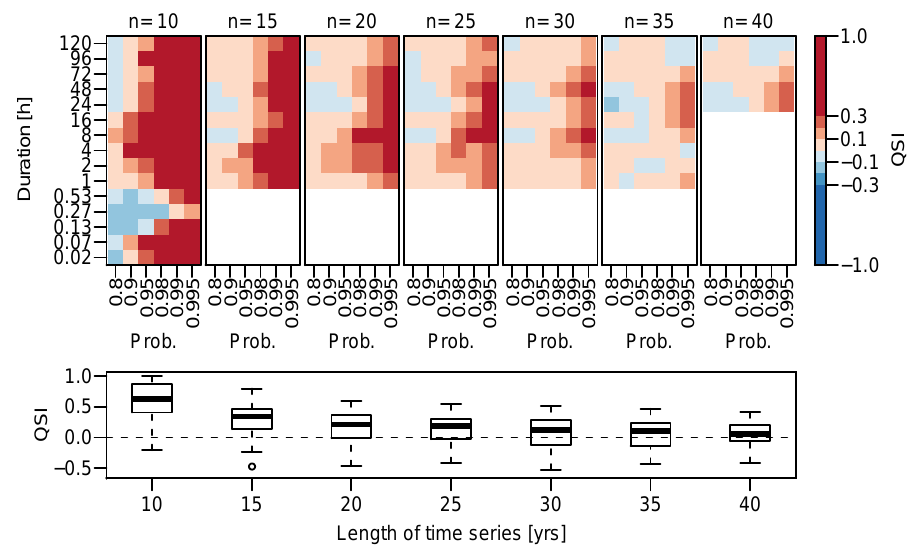
Figure 4. Dependence of the spatial d-GEV model performance on length of the training time series. Upper panel: Average Quantile Skill Index QSI d ( p ) for different durations d and probabilities p as seen in Figure 3 but rotated. Different columns represent QSI d ( p ) for different numbers of years in the training set n train . Lower panel: Boxplot of the Quantile Skill Index QSI s , d ( p ) with probability p = 0.99 dependent on the length of the training time